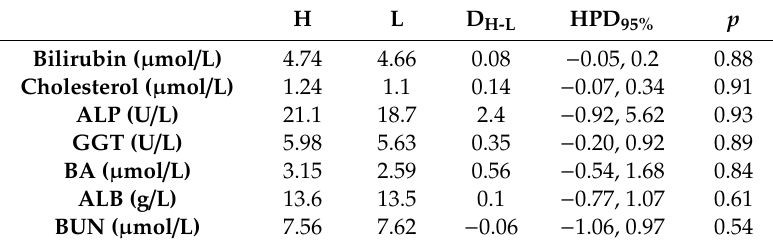
Table 4. Biochemical parameters concentrations in female rabbits from the high and the low line. H L D